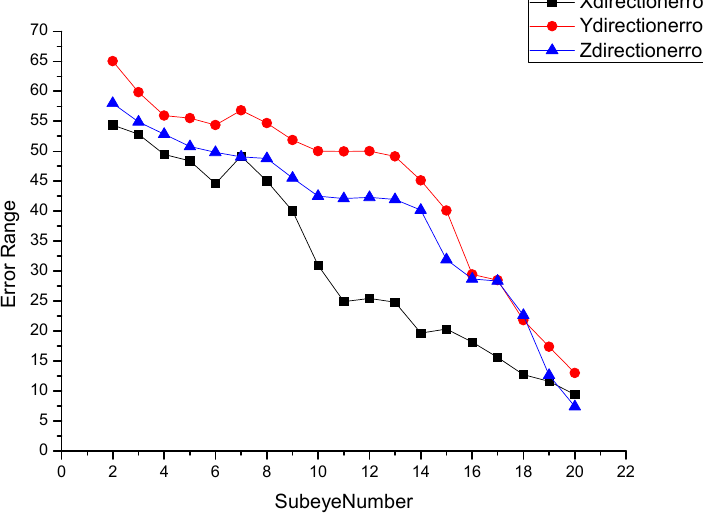
Figure 11. Error in the three-dimensional coordinates of the target point as a function of the number of captured sub-eyes.